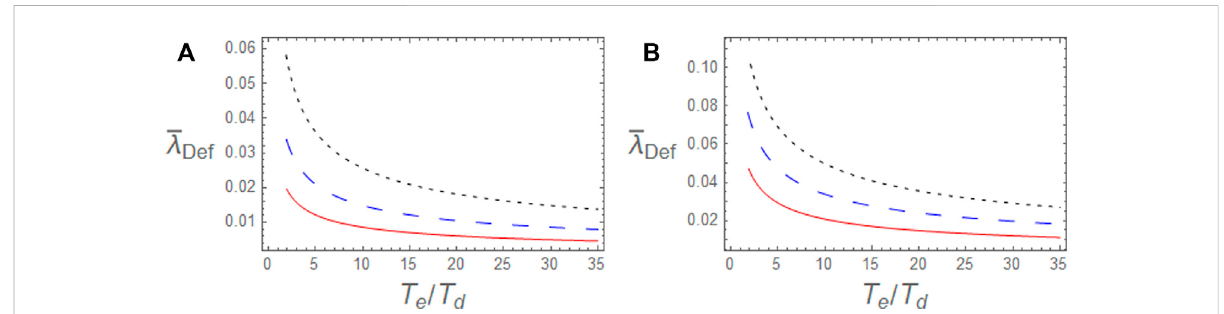
FIGURE 2 The pro fi les of the effective-shielding length ( (cid:2) λ Def ) are shown as a function of electron-to-dust temperature ratio ( T e / T d ) for varying (A) the polarizationcoef fi cient R (cid:1) 0 . 057(black dashedcurve),0.058(bluedashed curve),0.059 (redsolidcurve) with z d 0 =4007, and (B) thedust charging state z d 0 = 2000, 3000, 4990 at η = 10 – 5 . All other parameters are the same as given in Section 3.